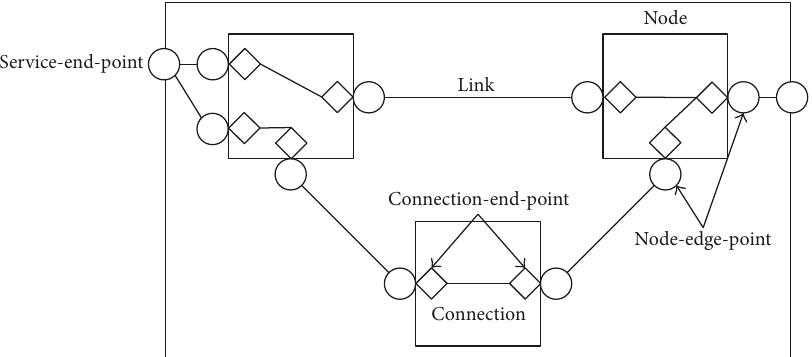
Figure 1: TAPI topology components.